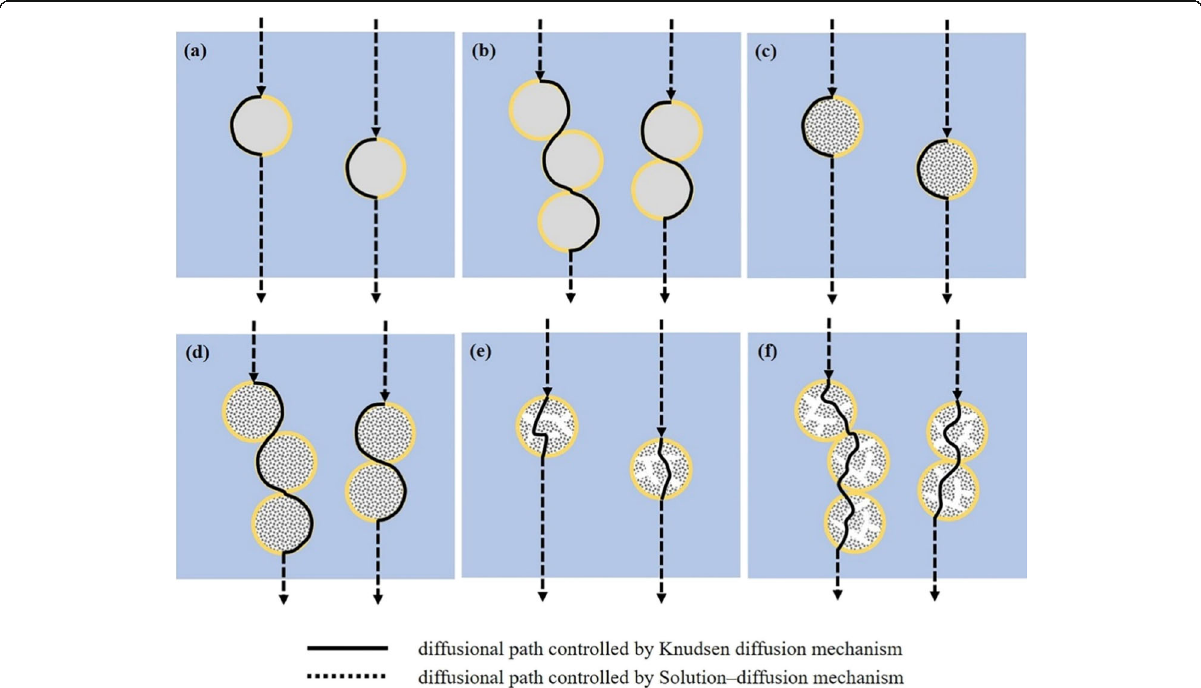
Fig. 4 Diffusional path of mixed matrix membranes containing ( a , b ) non-porous silica, ( c , d ) microporous silica, ( e , f ) mesoporous silica, adapted from Park et al.